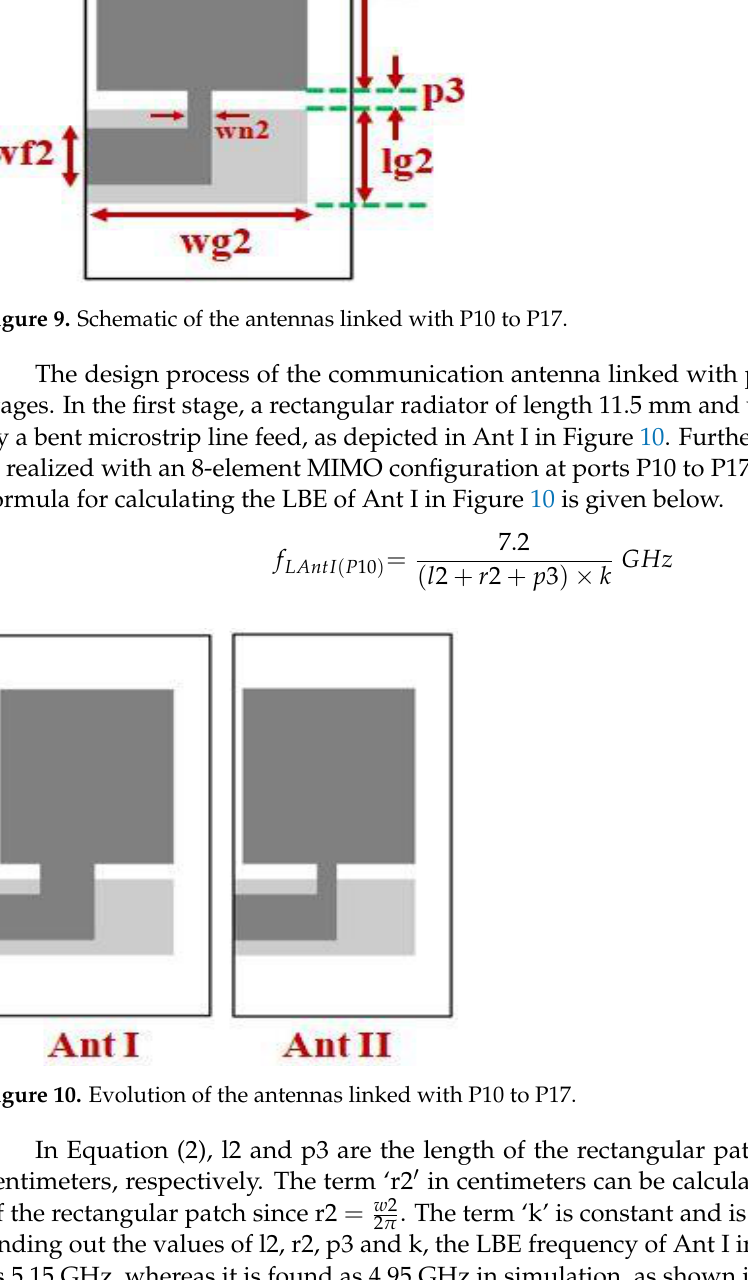
Figure 11 . Reflection coefficients of the antennas in intermediate steps of the antenna linked with port 10 .